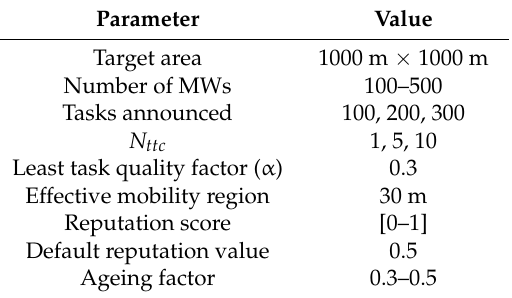
Table 2. Parameters for the evaluation criteria of RQRP and its